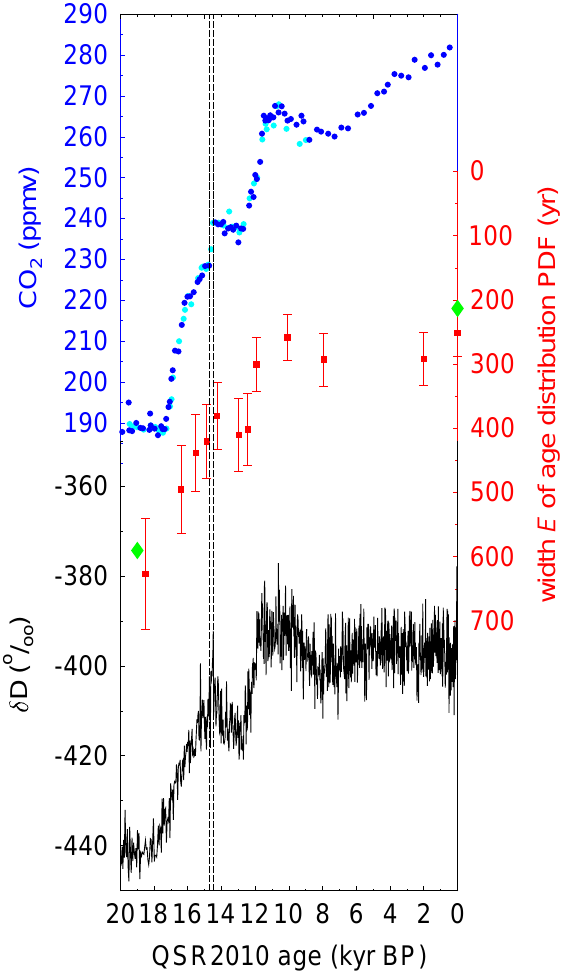
Fig. 3. Evolution of the width E of the age distribution PDF ( ± 1 σ ) during the last 20kyr (red squares) calculated with a firn densifi- cation model including heat diffusion (Goujon et al., 2003). Green diamonds represent the results for the LGM and pre-industrial cli- mate with another firn densification model (Joos and Spahni, 2008). Please note reverse y-axis. Top: EDC CO 2 (Monnin et al., 2001; Lourantou et al., 2010). Bottom: EDC δ D data (Stenni et al., 2001). All records are on the new age scale QSR2010 (Lemieux-Dudon et al.,